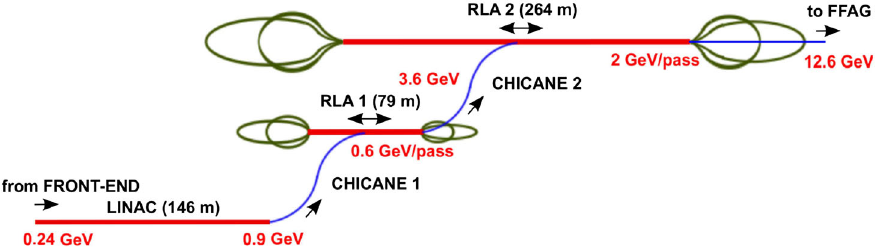
FIG. 8. Schematic layout of the muon acceleration to 12.6 GeV for the baseline lattice (scheme 1) showing the status in April